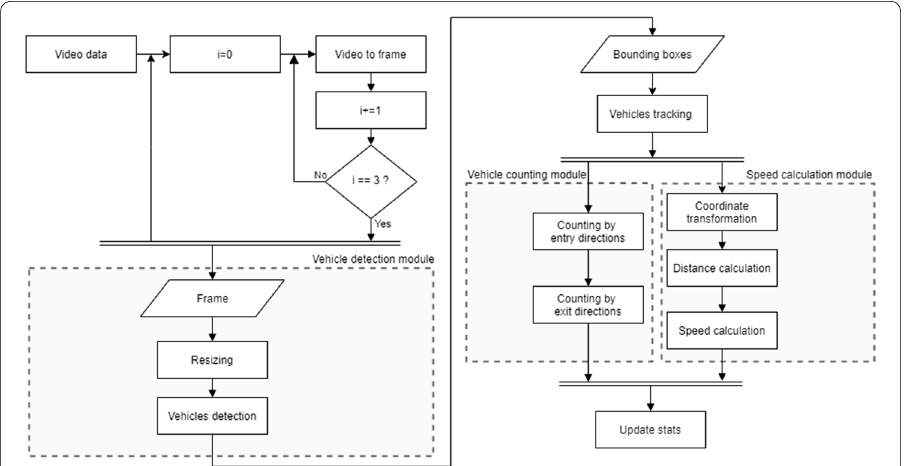
Fig. 2 An algorithm for determining the average speed and direction of